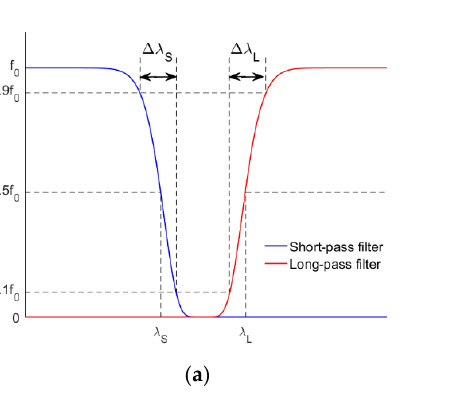
Figure 4. ( a ) Schematic diagram showing the specification definitions of the short-pass and long- pass optical filters. ( b ) Spectral sensitivity examples of the fourth channel using the short-pass and long-pass optical filters, where λ S = 528 nm and λ L = 585 nm. Refer to Section 2.1 for details. To sum up, four types of quadcolor cameras were considered, which are the